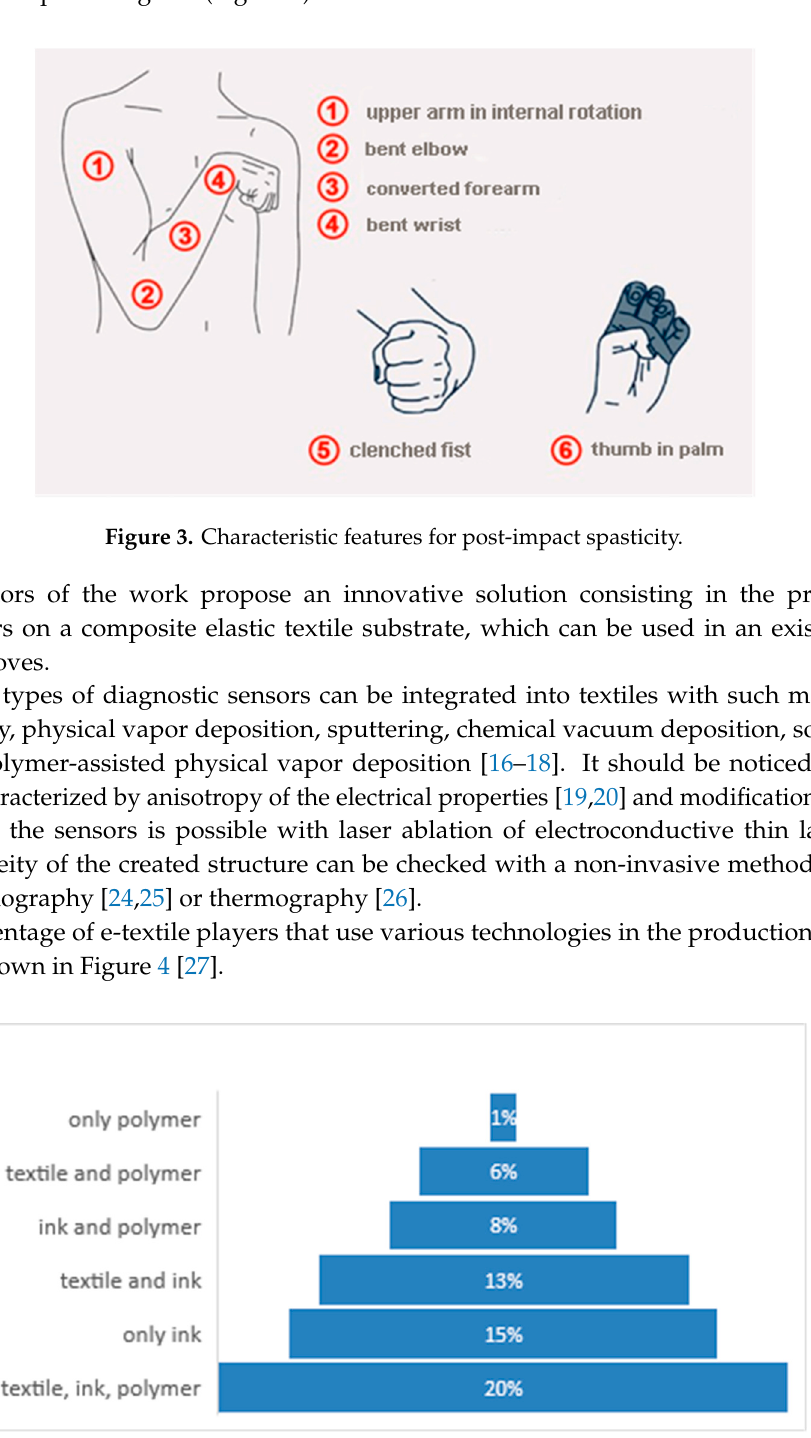
Figure 4. The percentage of e-textile players that use various technologies.